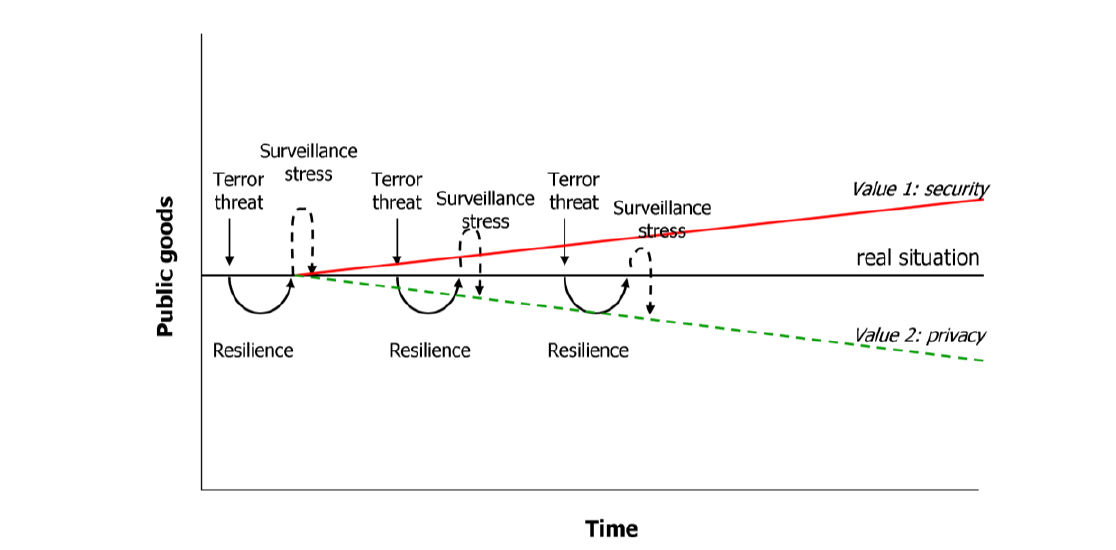
Figure 10. Terror threats and surveillance stresses in a security/privacy trade-off